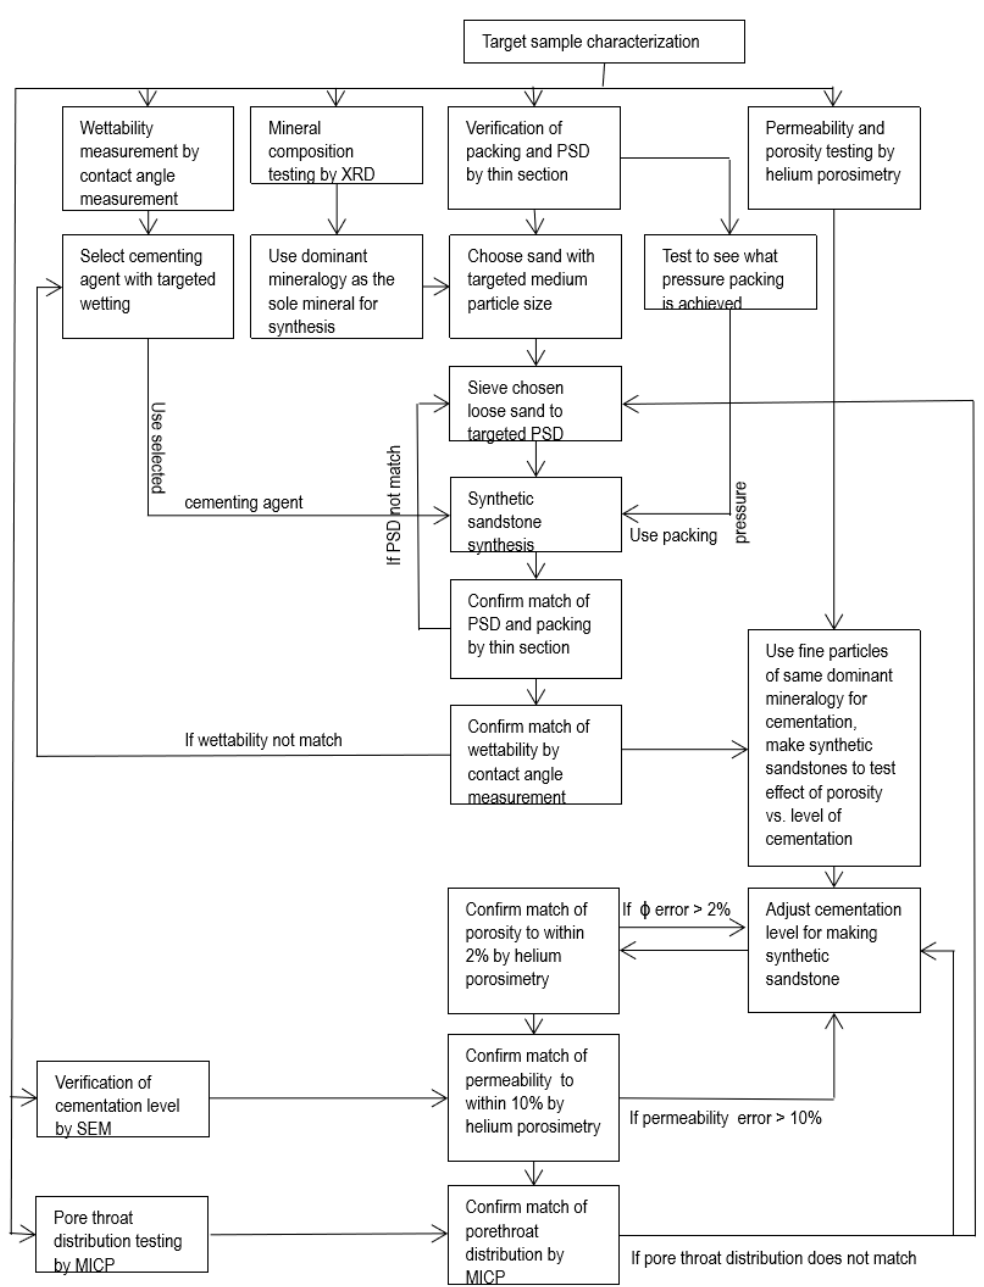
Figure 3. Methodological flow chart for concurrent multi-parametric physical modeling of an unfractured homogeneous sandstone.